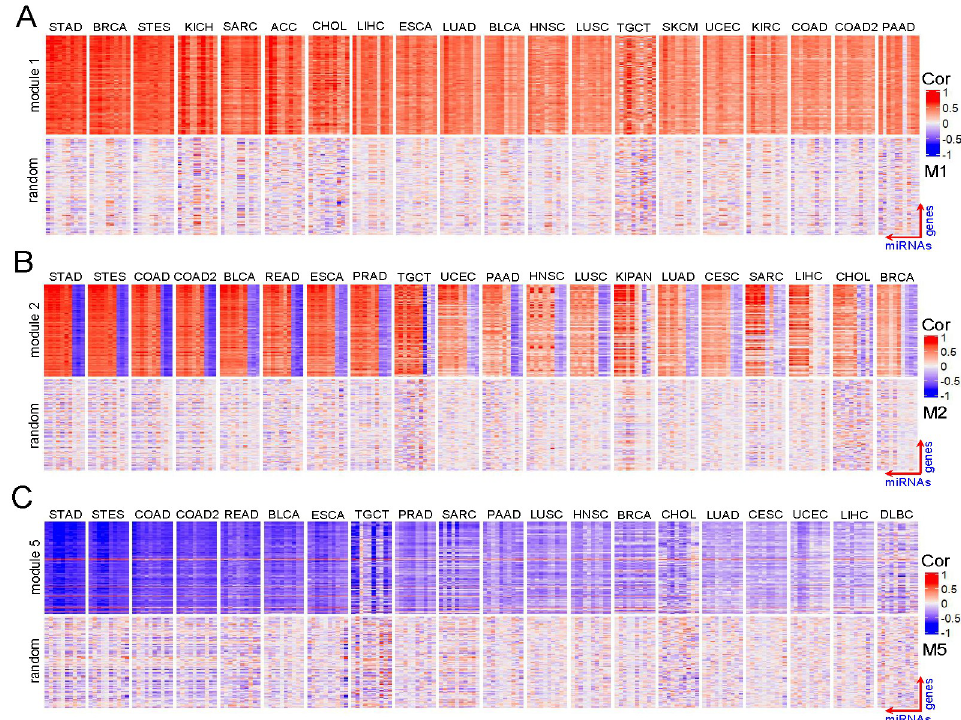
Fig 3. Heatmap of cancer-miRNA-gene modules identified by TSCCA in the TCGA dataset. The top half of (A) corresponds to the module 1 (row corresponds to gene, column corresponds to miRNA) and the lower part of (A) is a random module for comparison. Similar setting is used for module 2 and module 5 in (B) and (C) respectively. (A), (B) and (C) show three different co-expression patterns.